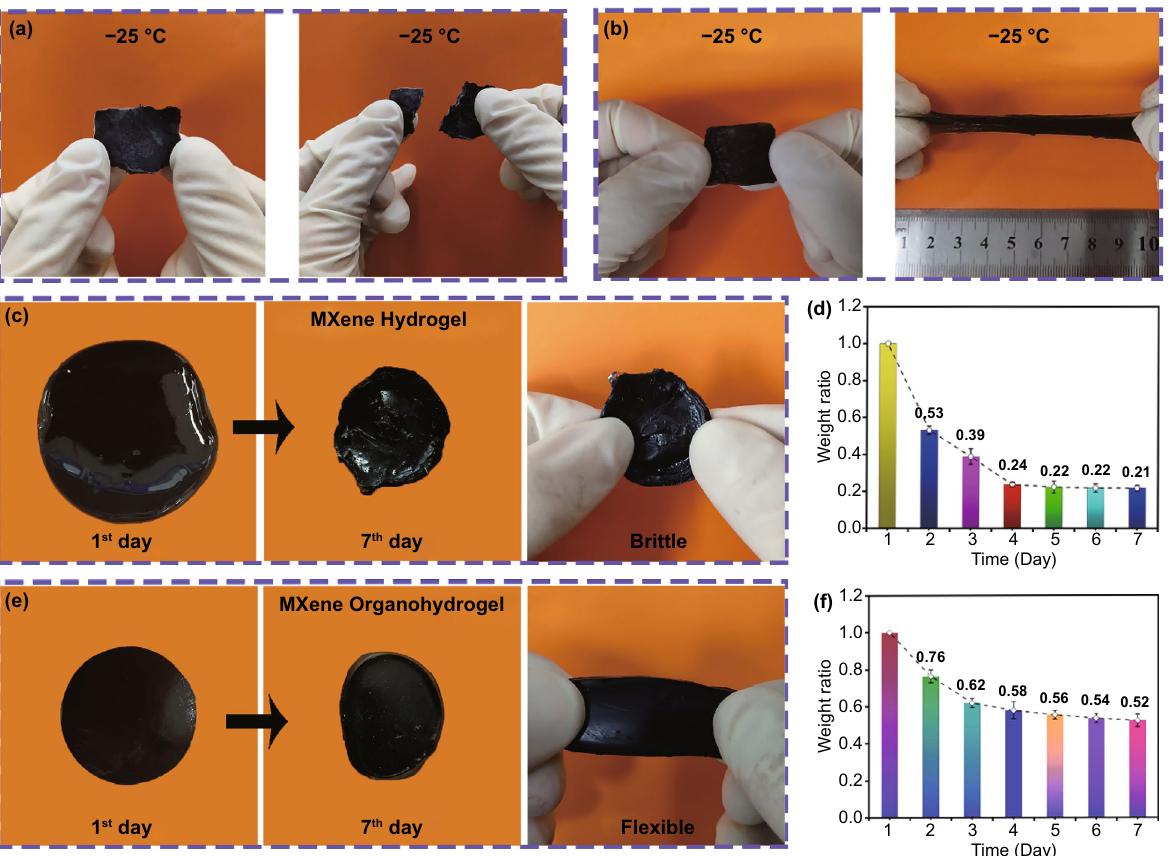
Fig. 3 Low-temperature tolerance of a MXene hydrogel (25 × 10 × 3 mm 3 ) and b MXene organohydrogel (original size: 25 × 10 × 3 mm 3 ). c Photos showing MXene hydrogel on the 1 and 7 days (original size: diameter of ~ 30 mm, thickness of ~ 3 mm; final size: diameter of ~ 20 mm, thickness of ~ 2.7 mm). d Change of weight ratio of MXene hydrogel during 7 days of storage. e Photos showing MXene organohydrogel on the 1 and 7 days (original size: diameter of ~ 25 mm, thickness of ~ 4 mm; final size: diameter of ~ 20 mm, thickness of ~ 4 mm). f Change of weight ratio of MXene organohydrogel during 7 days of